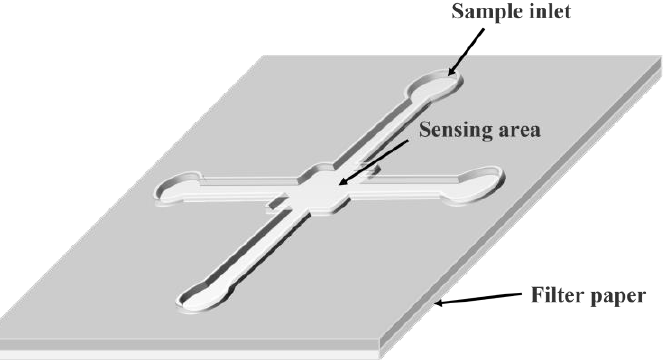
Figure 4. Schematic diagram of a paper-based microfluidic chip.